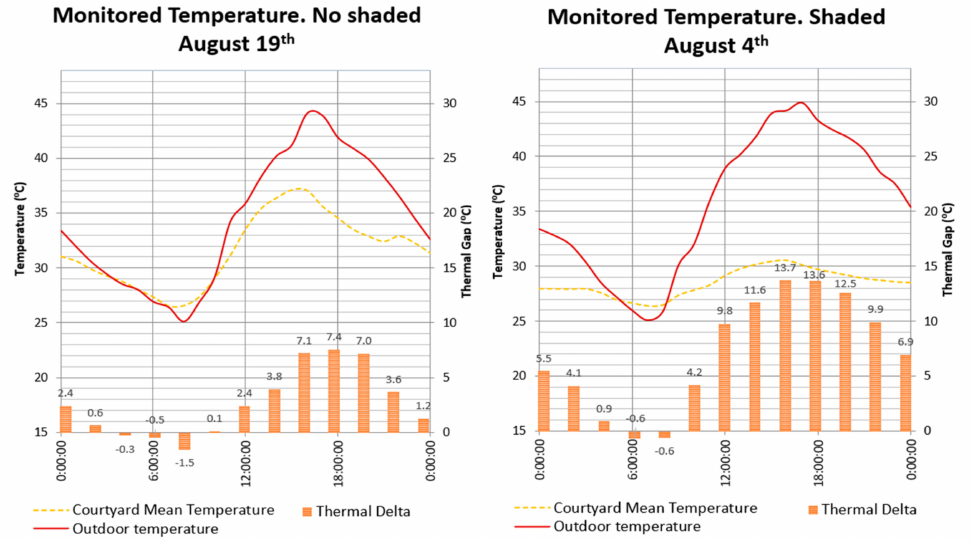
Figure 3. Monitored outdoor and courtyard air temperature on the selected